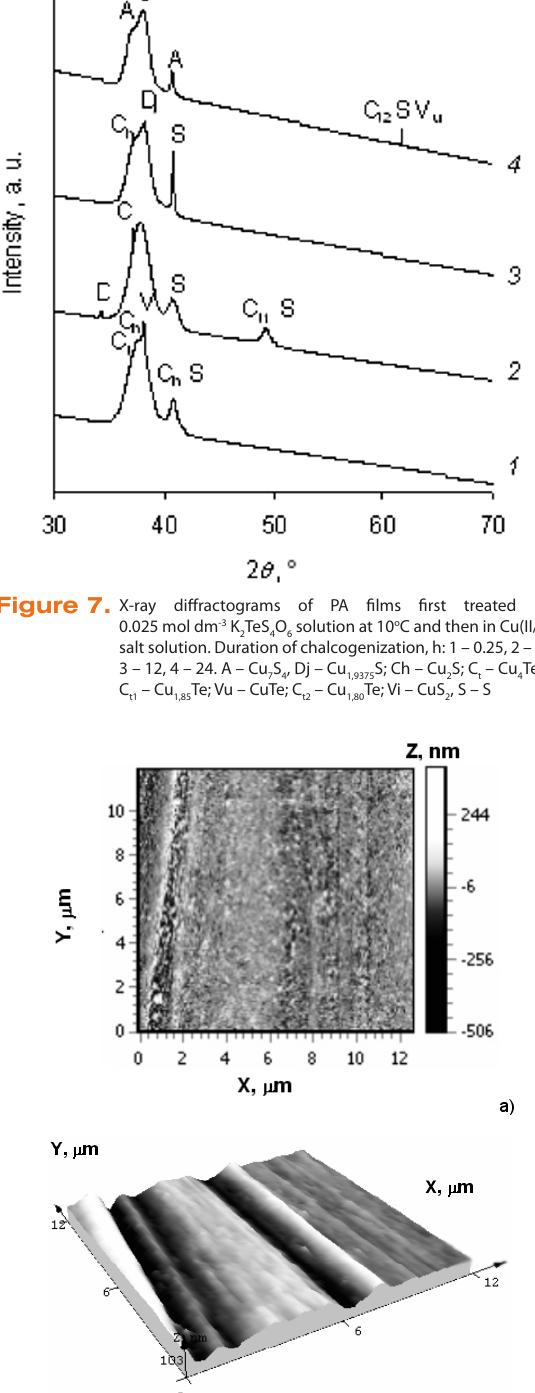
S–Cu Te layers formed x y TeS O 2 4 6 solution and then treated with Cu(II/I) solution